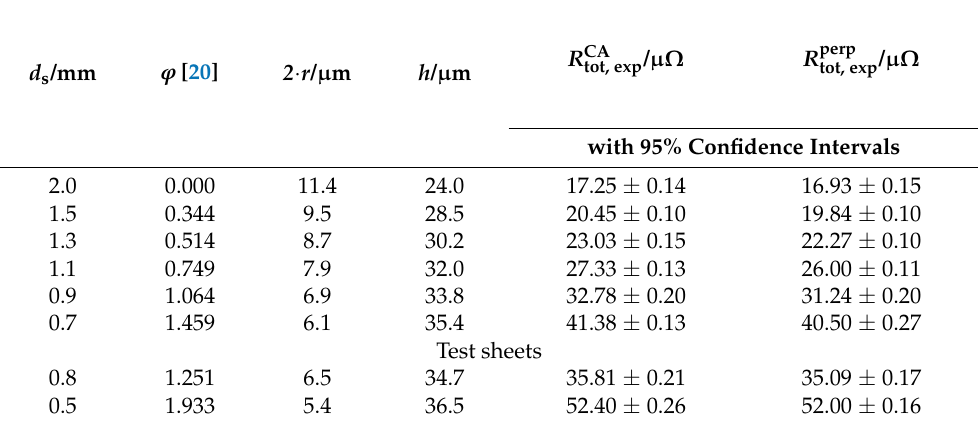
Table 2. Average grain sizes (radius and height) and measured electrical resistance in ( R CA perpendicular to ( R perp ) the rolling direction of different sheets. The sheets marked as test sheets tot, exp serve the purpose of